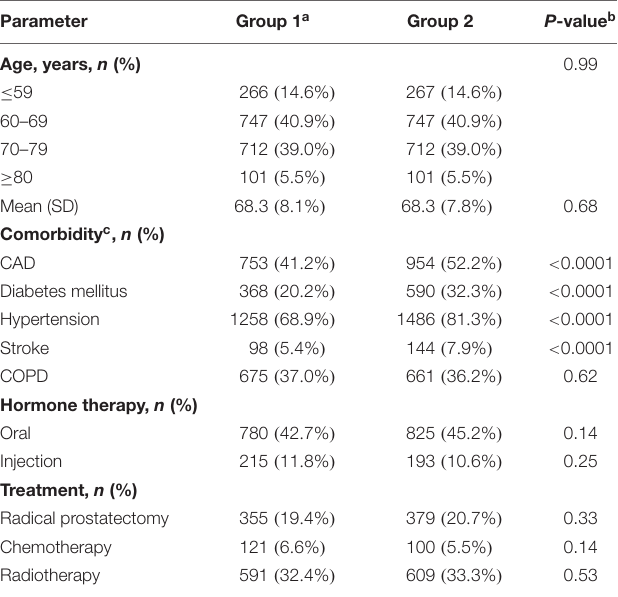
TABLE 1 | Demographic characteristics of PCa patients with hyperlipidemia by